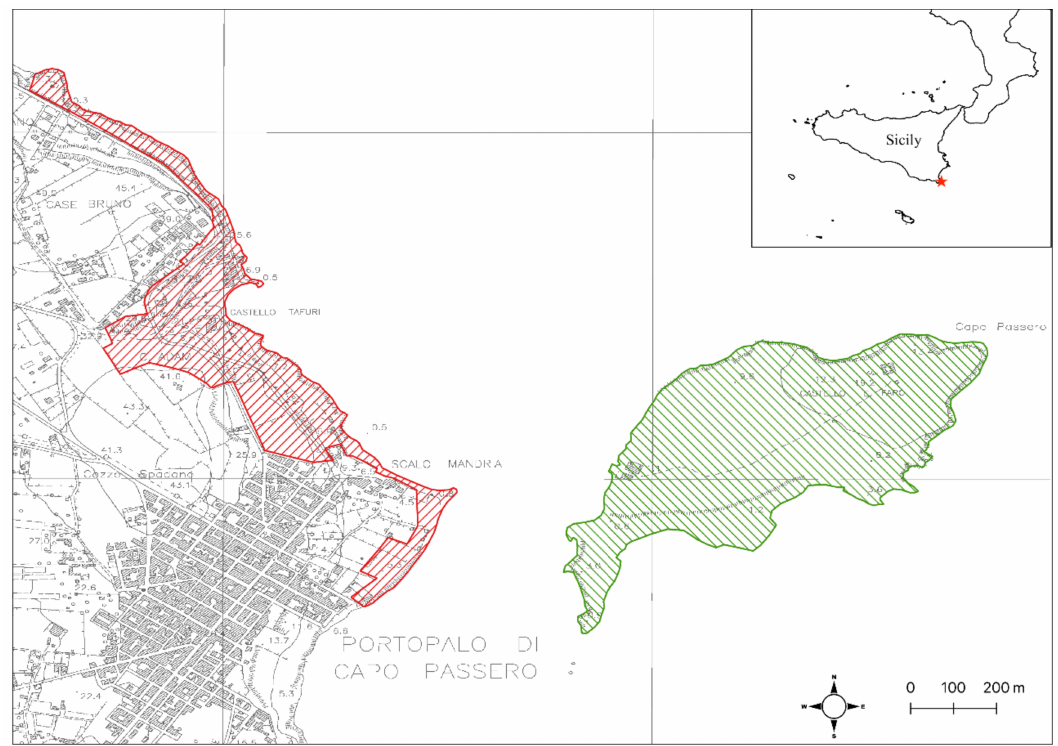
Figure 6. Proposed enlargement on the mainland of the boundaries of the SAC ITA090001 “Isola di Capo